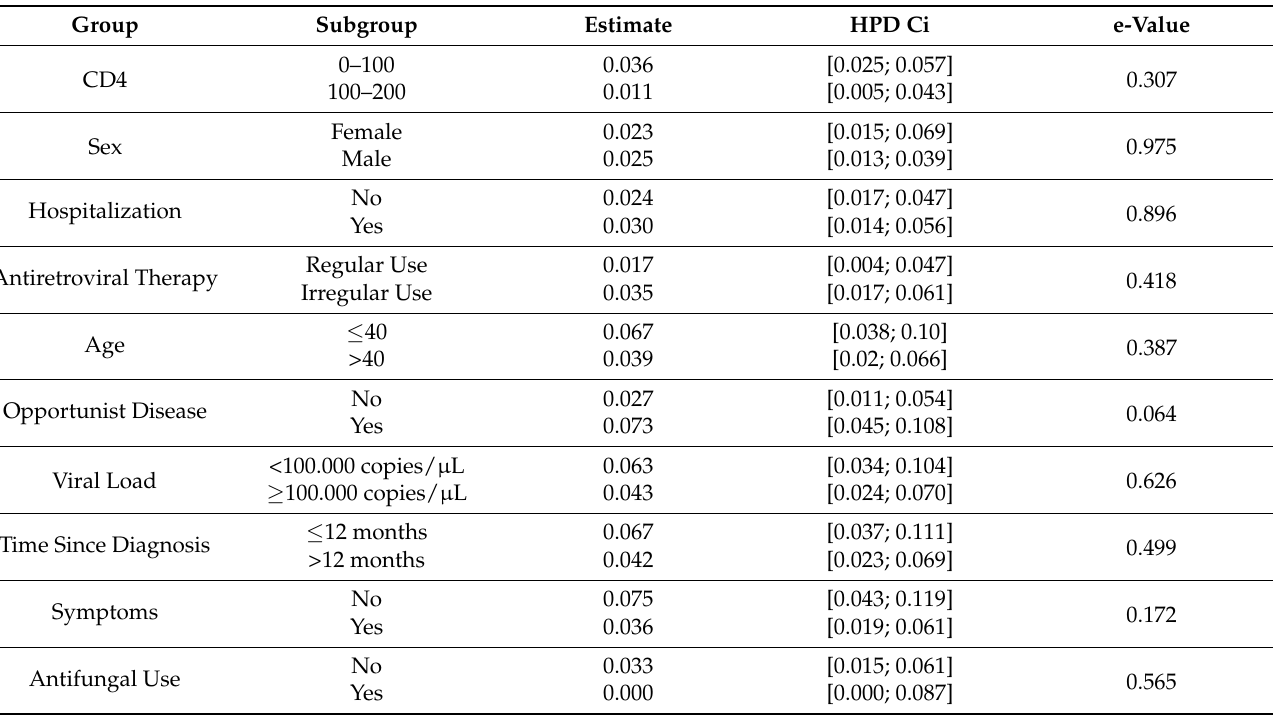
Table 5. Estimated prevalence of positive LFAs on the posterior model and HPD credible intervals for each group and FBST evidence value for group comparison.